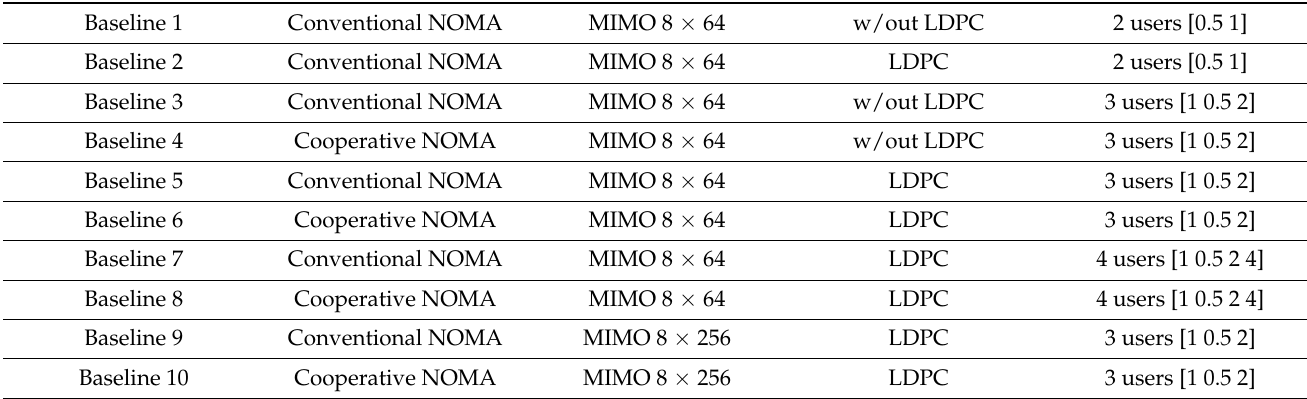
Table 1 presents a list of baseline simulations utilized in the different graphics. Table 1. List of Baselines utilized in